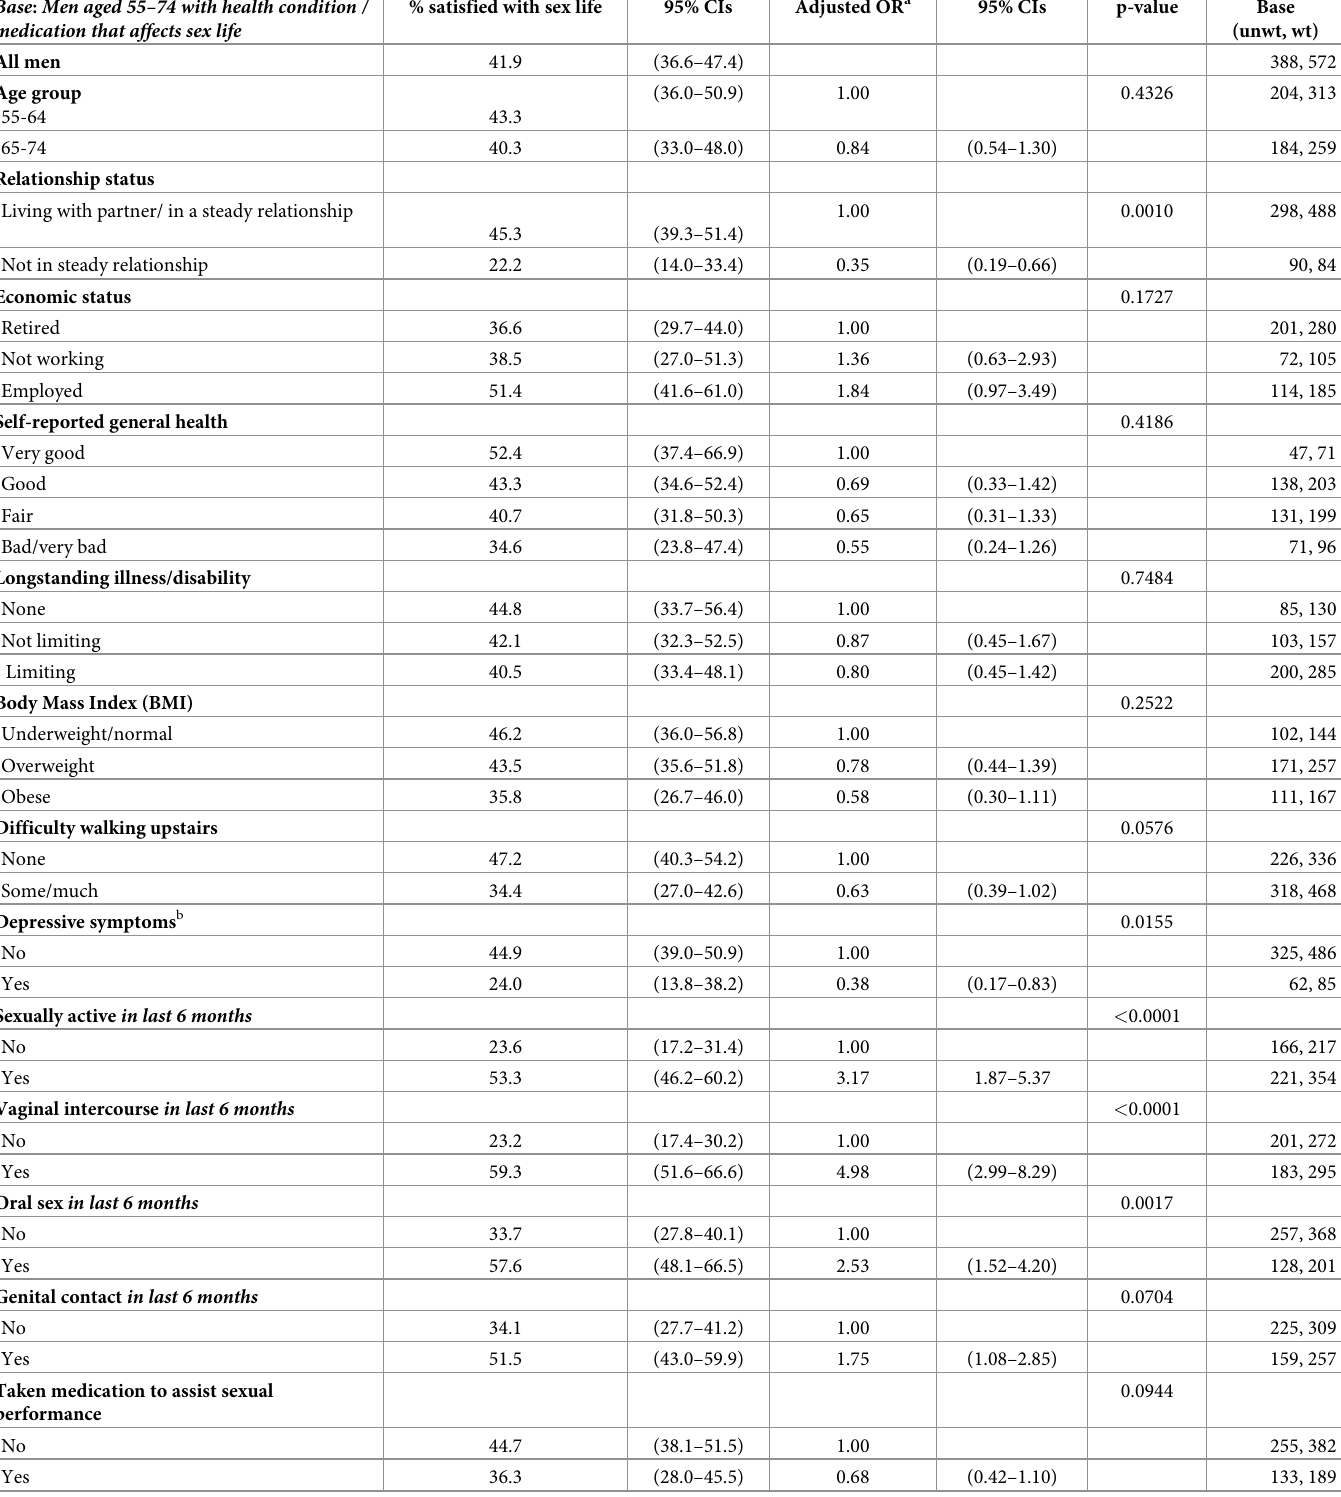
Table 5. Satisfied with sex life: